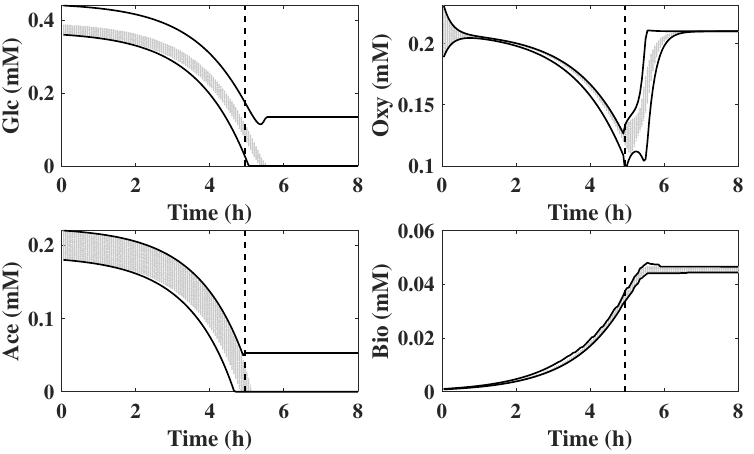
Figure 6. Comparison between MCA with bounds of 4 components estimated by SME with loud